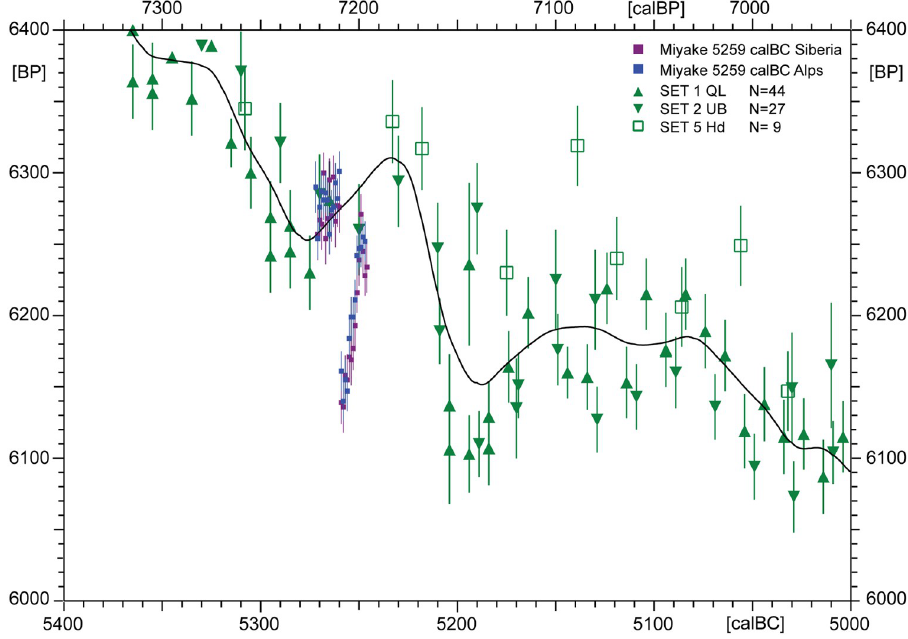
Fig 8. 14 C-data for the 5259 BC Miyake [19] measured on single tree rings of Siberian Larch (lila) and Alpine Larch (blue) compared to IntCal20 sets (green). The graph illustrates how difficult it can be to recognise Miyake events. Despite large amplitude (~ 100 BP), the excess 14 C is rapidly (within ~20 yrs) removed from the atmosphere. In consequence, the 5259 BC Miyake is hidden from the view of decadel/bidecadel IntCal20 tree-ring data. For clarity the IntCal20 data (from American and European trees) are shown without calendric scale error